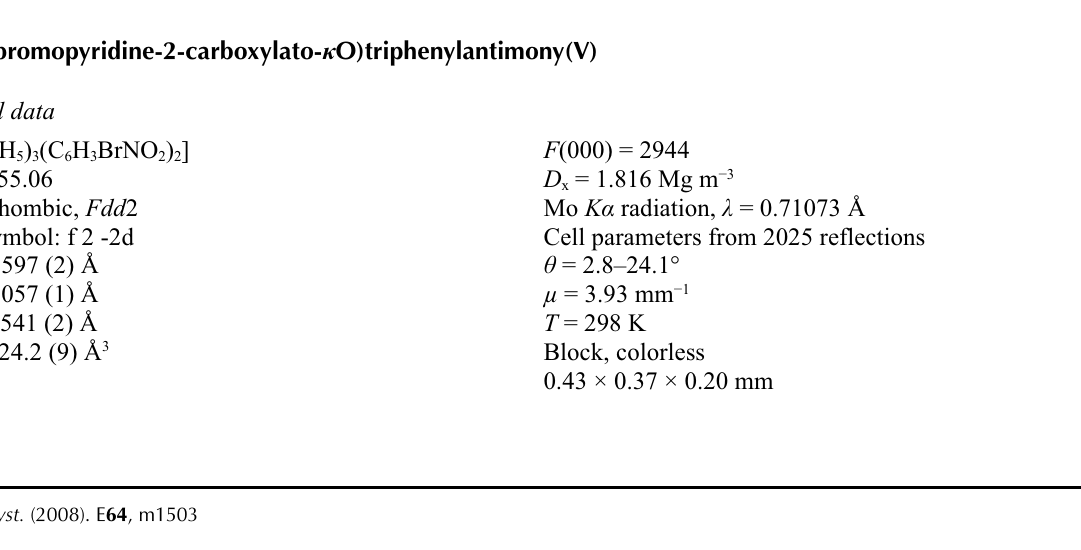
sup-3 Acta Cryst. (2008). E 64 , m1503